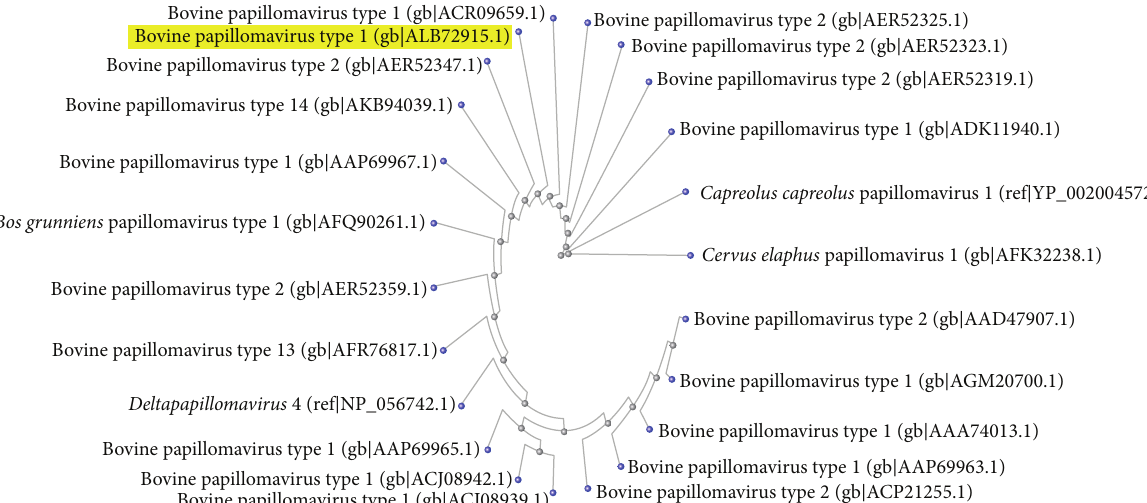
Figure 3: Phylogenetic tree showing the identified Iraqi BPV sequence. This is the first report of a BPV-1 sequence in Iraq (KT203919); the sequence was found to belong to the genus Deltapapillomavirus . The sequence was constructed via the neighbor-joining method using MEGA 6 software. Bovine papillomavirus type 2 (gb | AER52325.1)